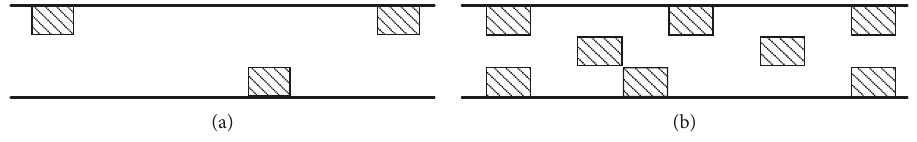
Figure 2: Comparison between PD scenarios of high and low densities: (a) f